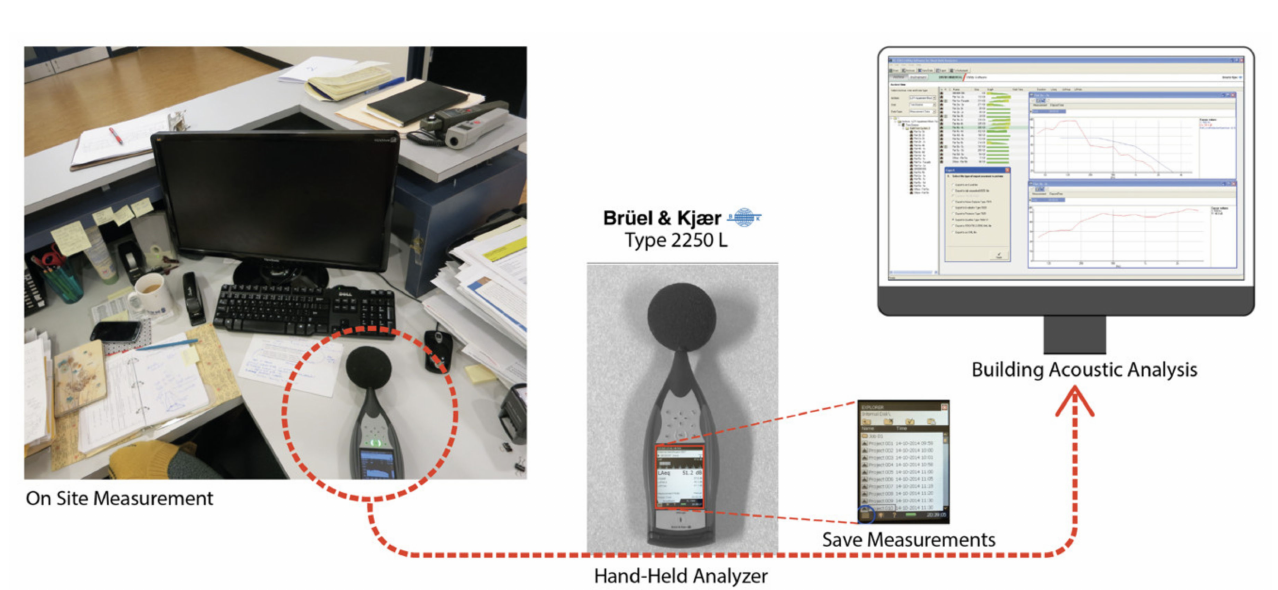
Figure 1. Class 1 sound measurement in the field using the handheld sound level meter 2250-L with microphone type